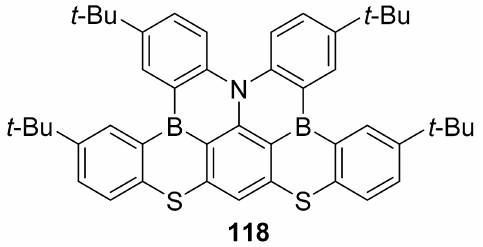
Figure 5. Structure of compound 118